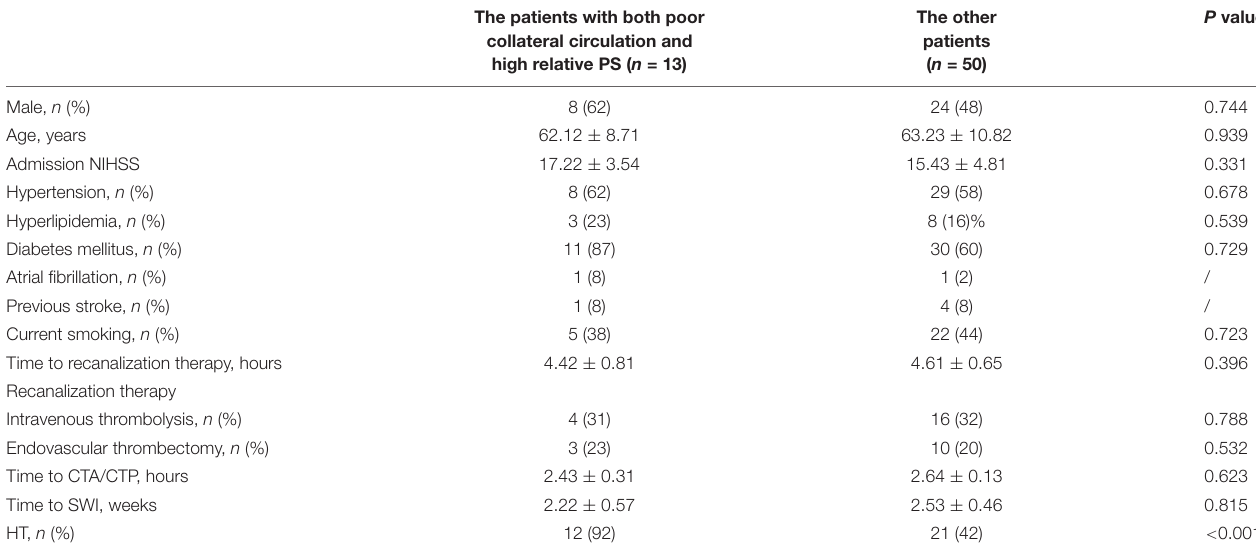
TABLE 1 | Clinical characteristics of patients.